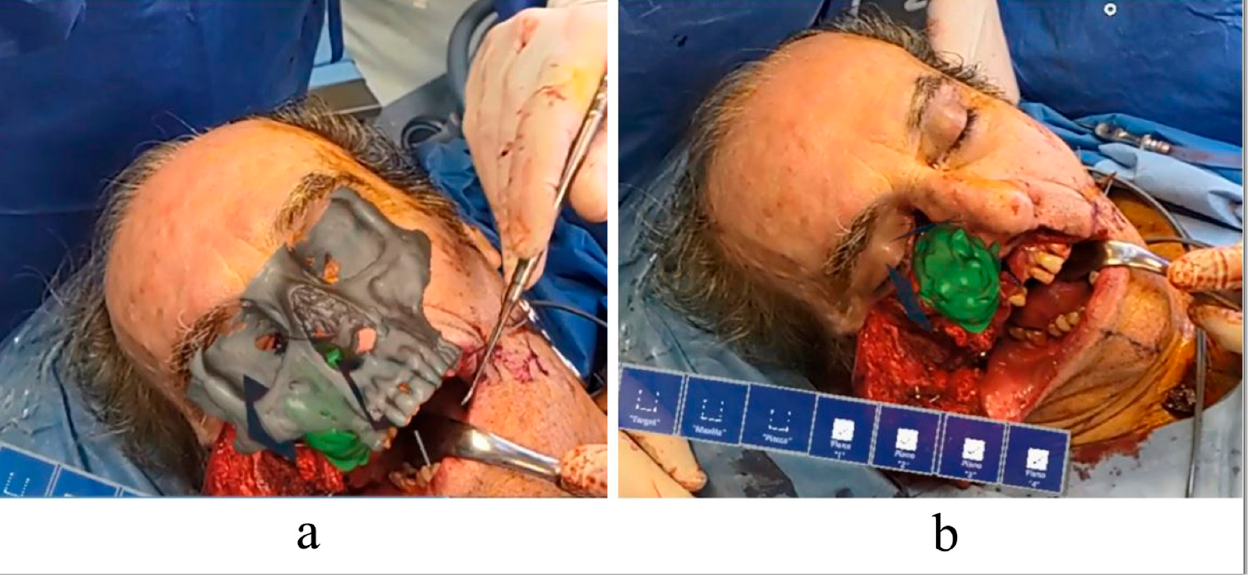
Figure 6. View of the surgical plan superimposed on the patient’s face. With and without virtual bone ( a , b ).